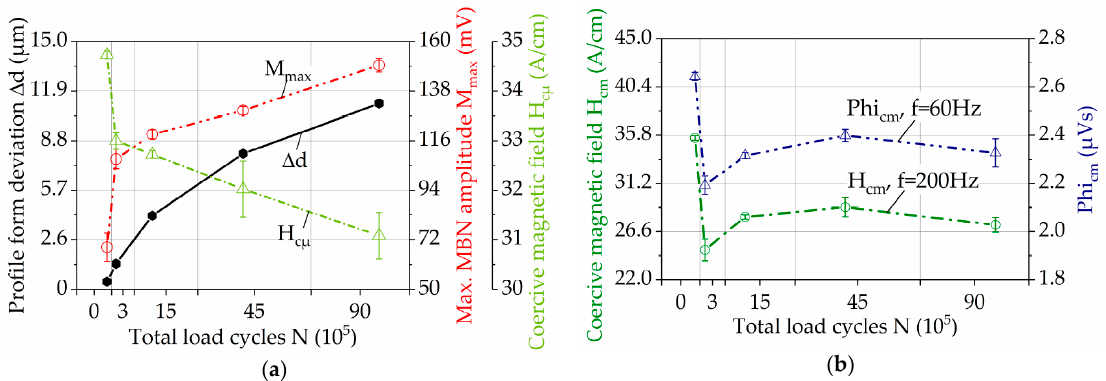
Figure 12. Results of micro-magnetic testing: ( a ) M max and H c µ by BN and IP, respectively, using 3MAII; ( b ) H cm and Phi cm by BN-analysis using 3MAII and FracDim, respectively.